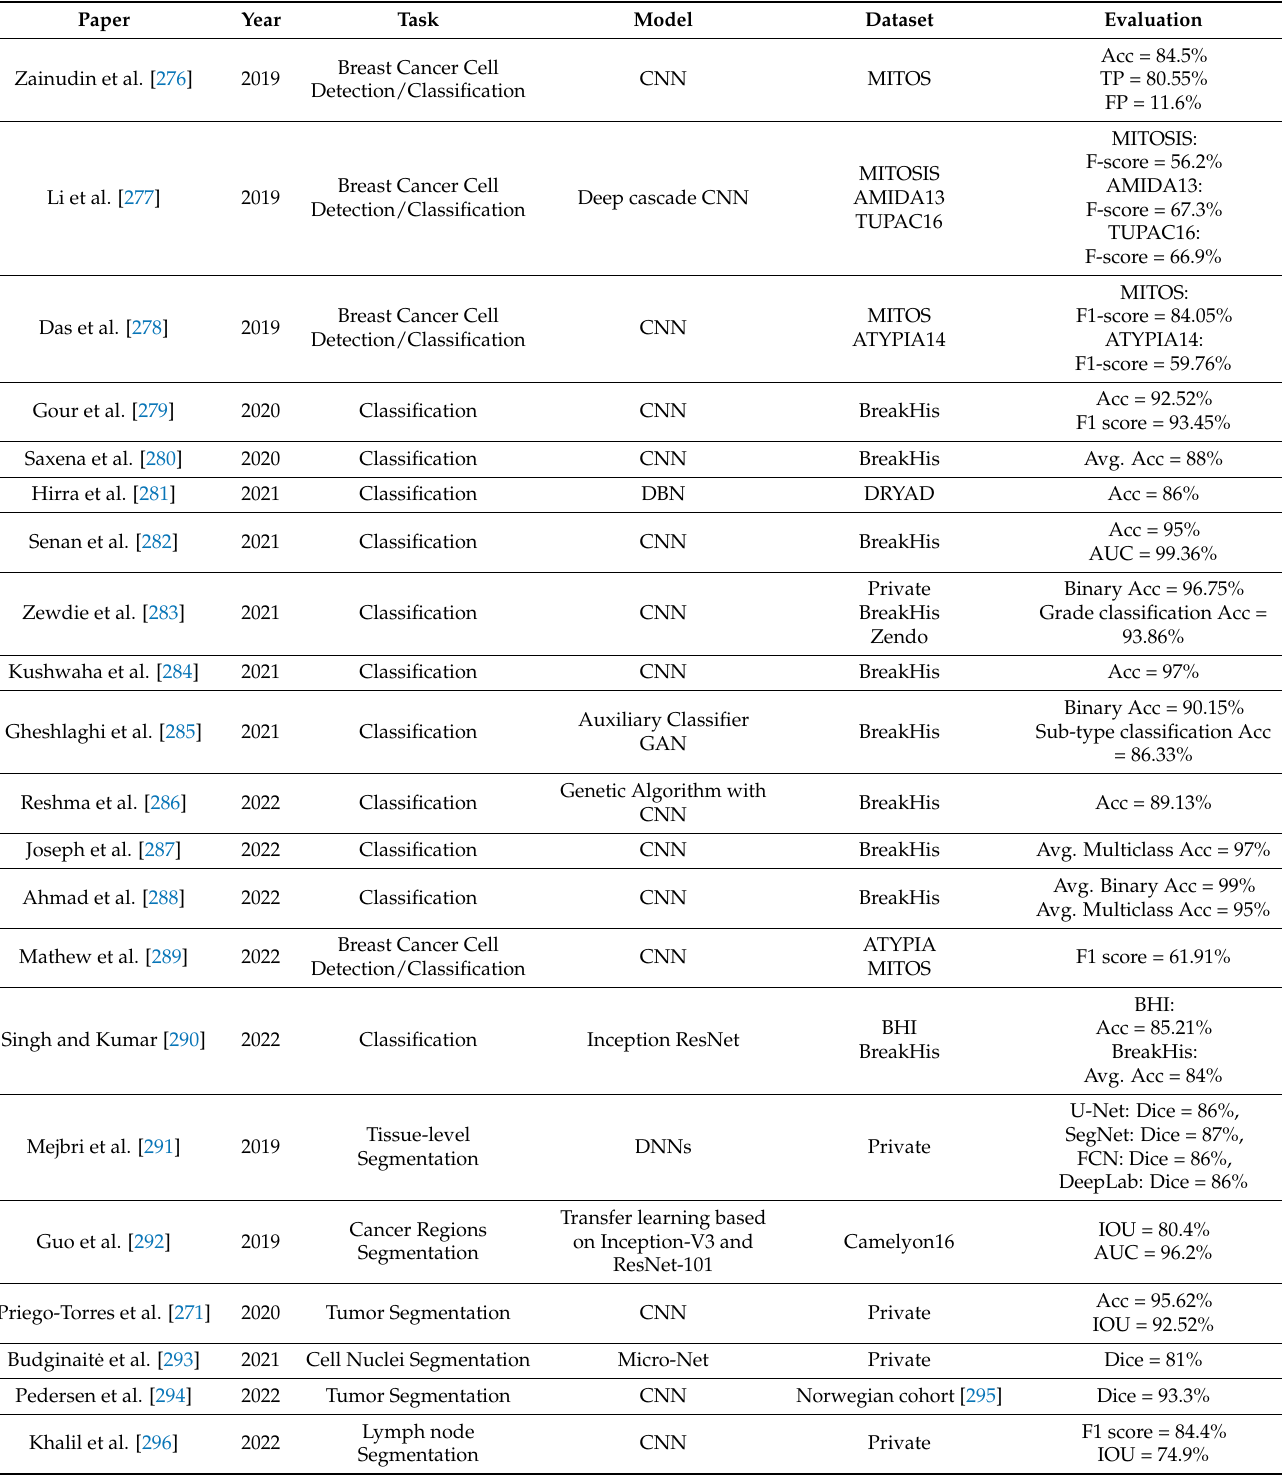
Table 6. The summary of the studies that used histopathology